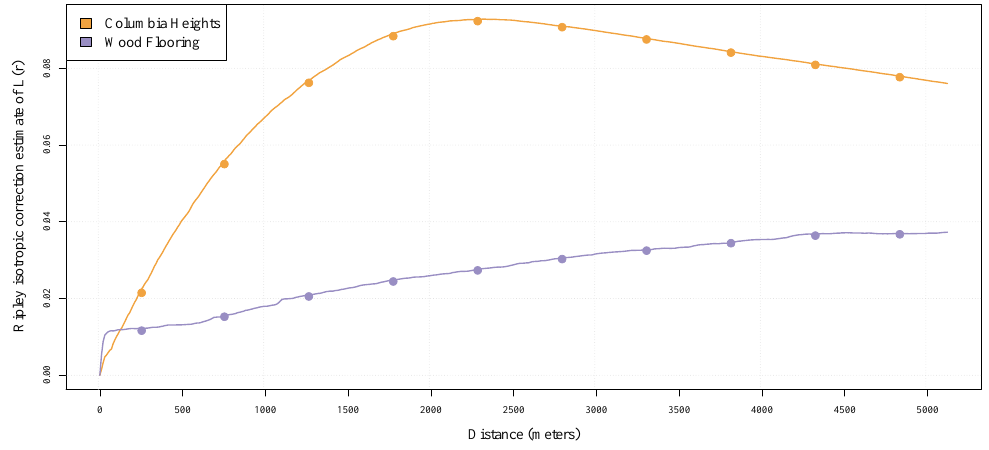
Figure 3. Ripley’s L function over 5 km for two n-grams, Columbia Heights (a neighborhood name) and wood flooring. The points show the averaged ‘binned’ values over 500